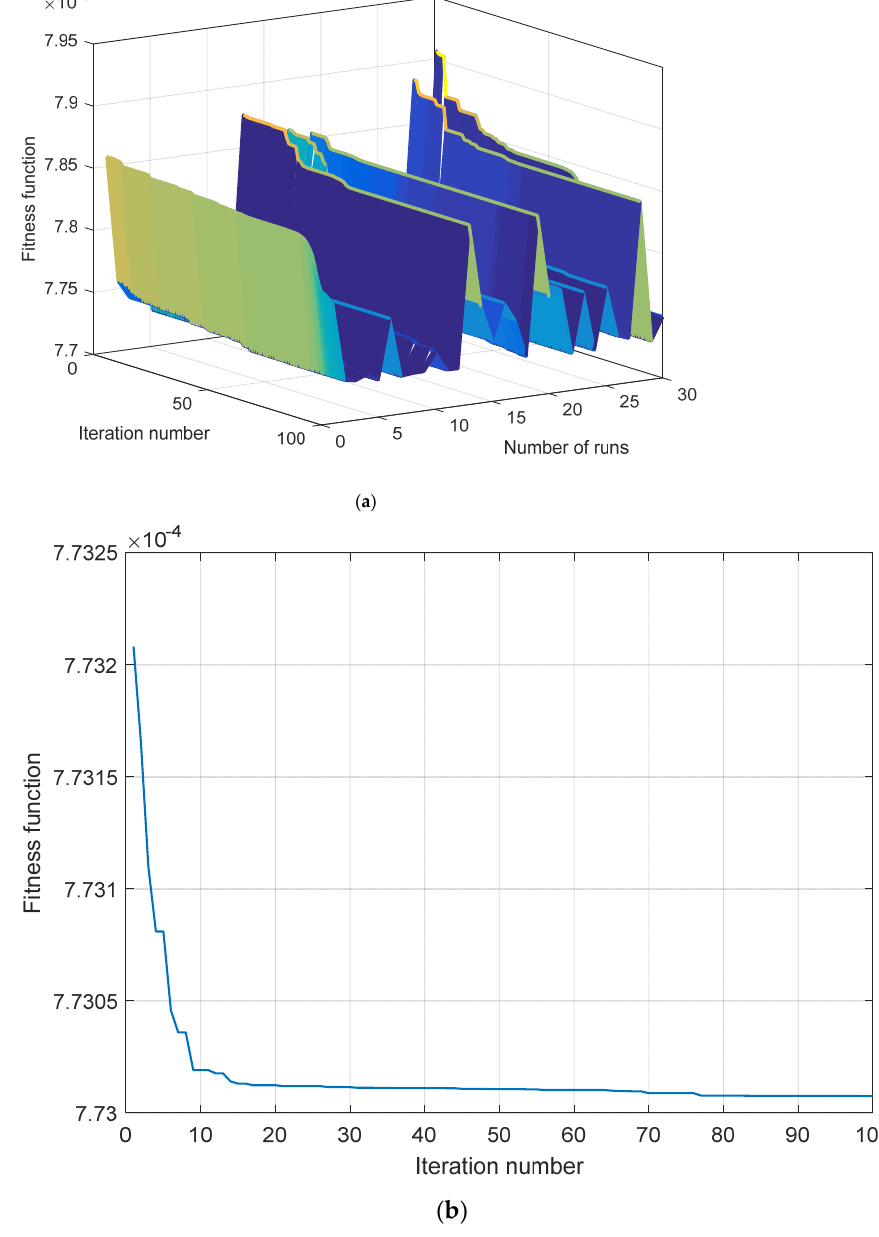
Figure 11. Proposed Algorithm 1: ( a ) fitness function for a different number of runs, and ( b ) mean fitness value versus iteration number.